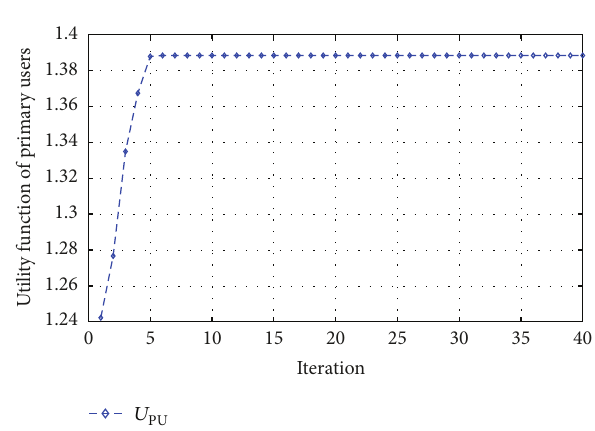
Figure 6: Utility function of the primary users with cooperative